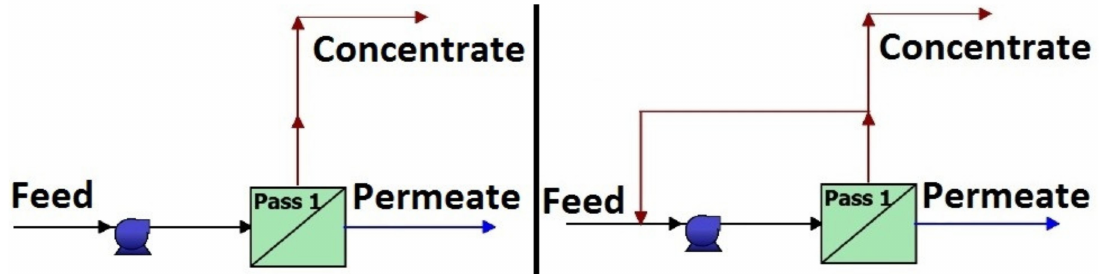
Figure 6. Flowsheets of reverse osmosis methods in WAVE program (right side: recycling version).